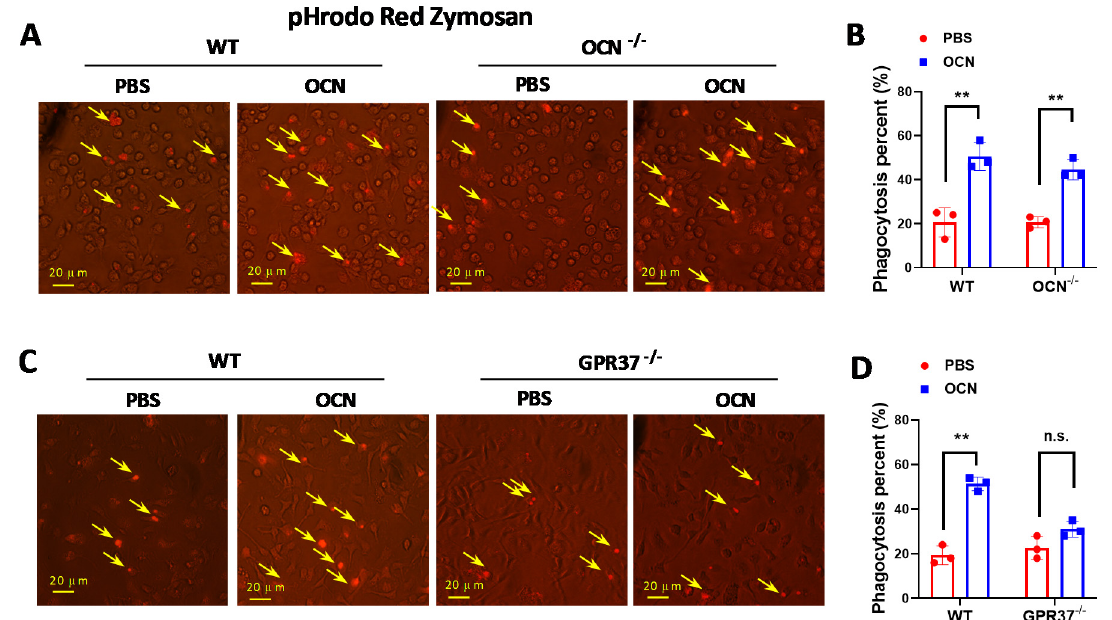
Figure 5. OCN promotes macrophage phagocytosis via GPR37. ( A ) Representative images of in vitro phagocytosis assay, in which pHrodo zymosan particles were incubated with peritoneal macrophages from WT or OCN − / − mice, treated with PBS or OCN (10 nM, 30 min, 37 °C). Red fluorescence suggests an intracellular update indicating phagocytosis. Scale bars: 20 µm. ( B ) Quantification of macrophage phagocytic activity of zymosan positives cells. Data are presented as mean ± SD ( n = 3 biological replicates), ** p < 0.01, as compared to PBS. ( C ) Representative images of an in vitro phag- ocytosis assay, in which pHrodo zymosan particles were incubated with peritoneal macrophages from WT or GPR37 − / − mice, treated with PBS or OCN (10 nM, 30 min, 37 °C). Scale bars: 20 µm. ( D ) Quantification of macrophage phagocytic activity of zymosan positives cells. Data are presented as mean ± SD ( n = 3 biological replicates), ** p < 0.01, as compared to PBS, and n.s. indicates not signif- icant.